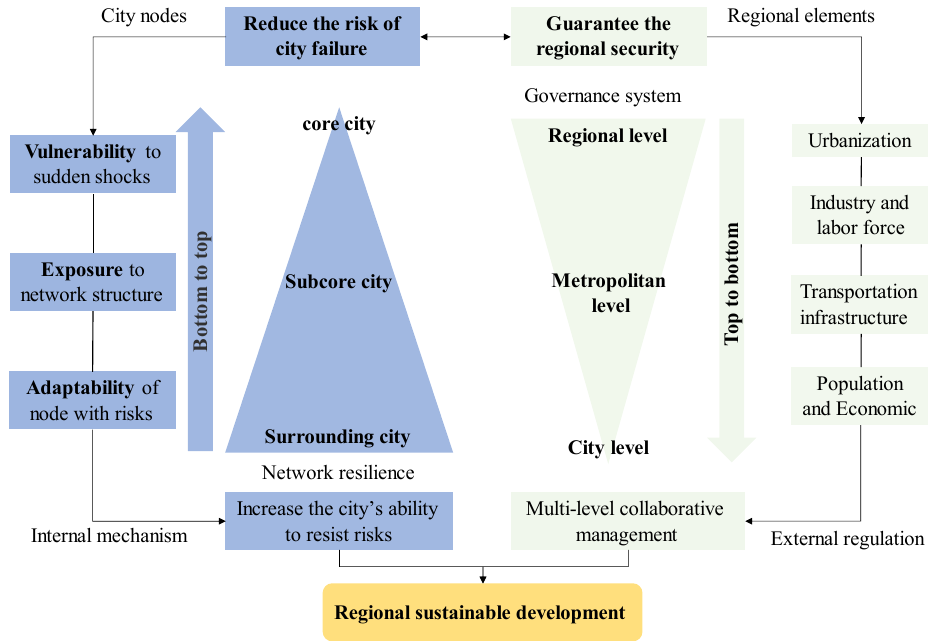
Figure 9. Optimization of network resilience framework.